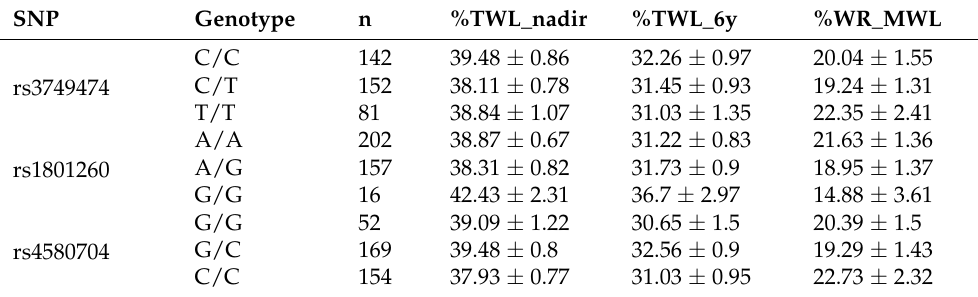
Table 3. Mean values of weight response variables by genotypes. Global cohort (N = 375).